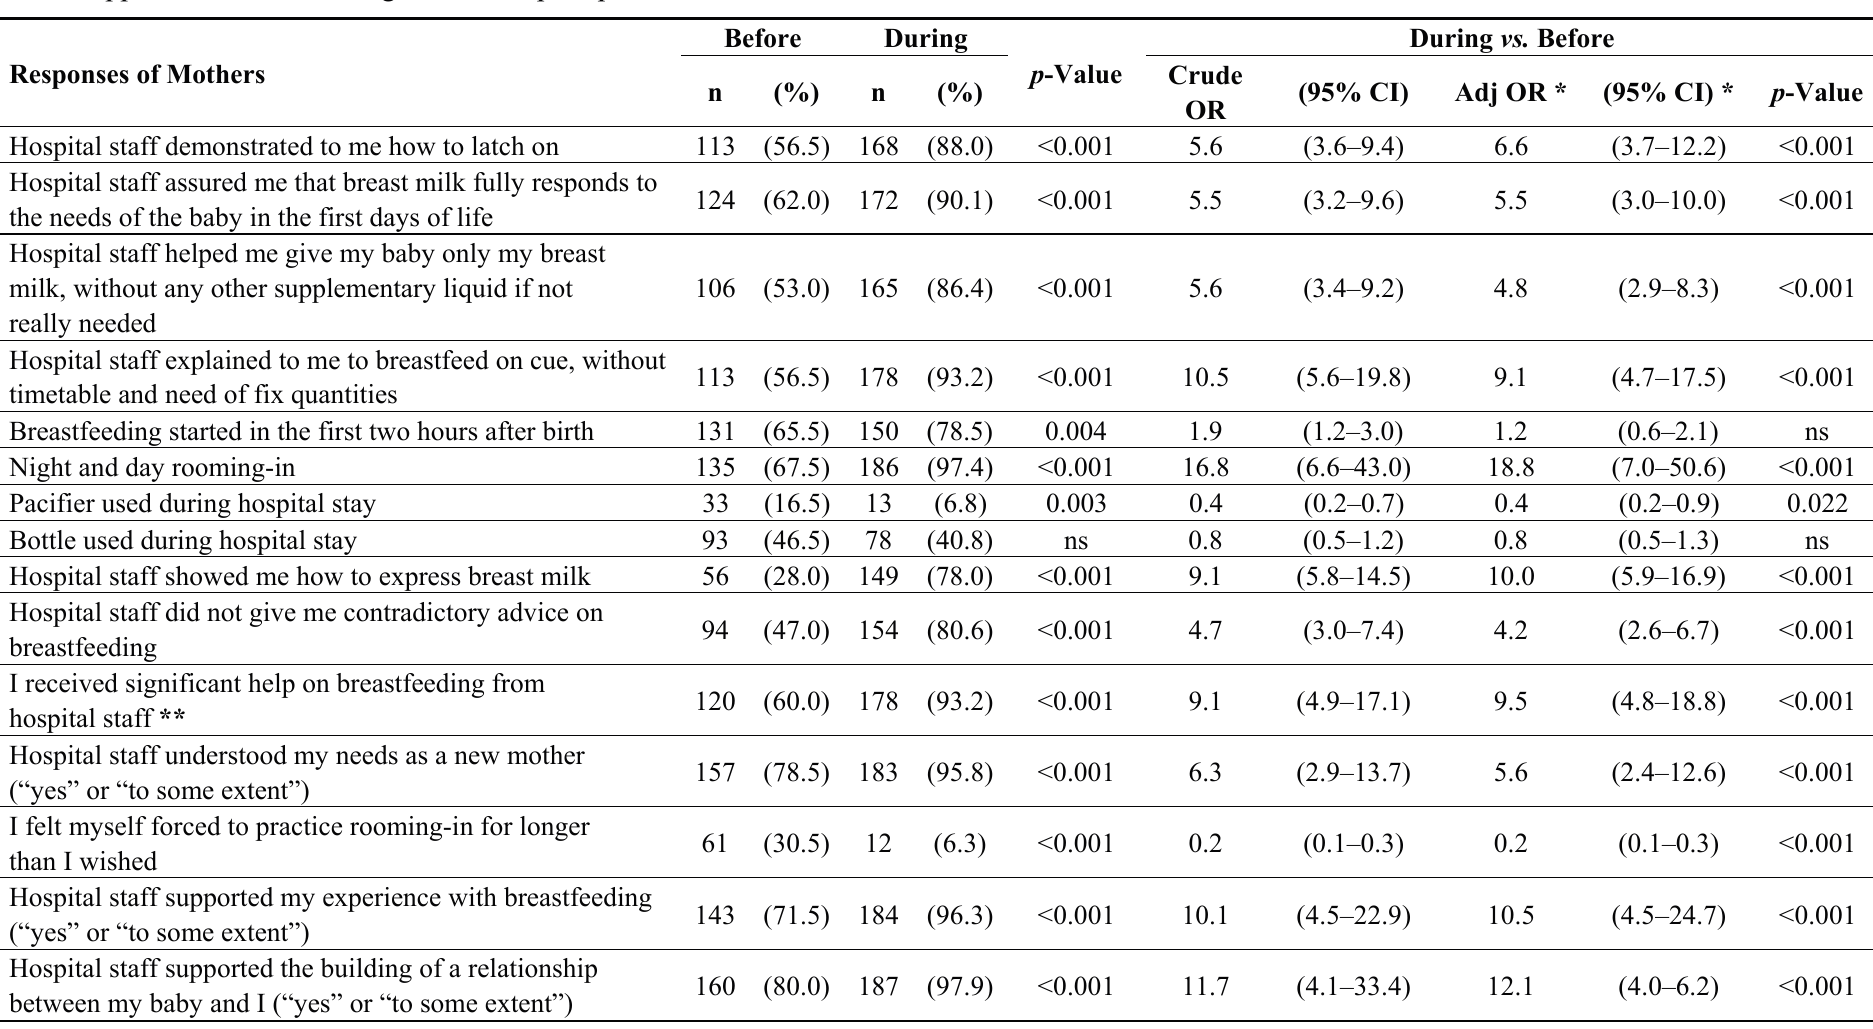
Table 2. Frequencies, crude and adjusted odds ratios for during vs. pre-intervention responses of mothers to statements regarding education, support, and breastfeeding-related hospital